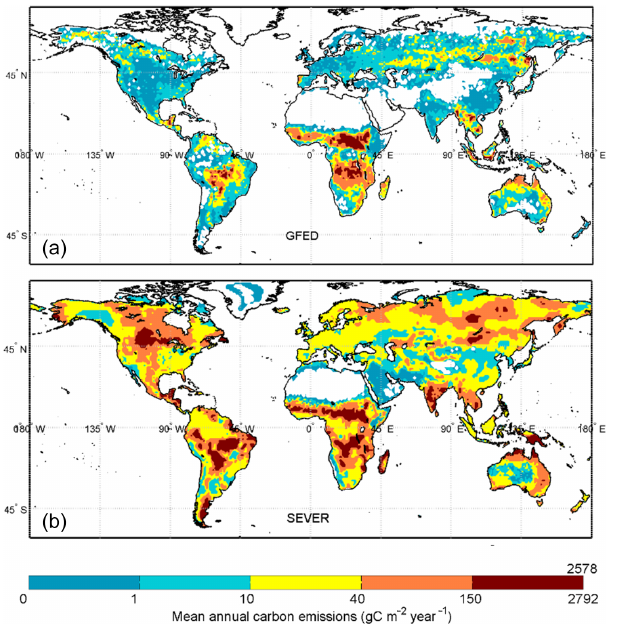
Figure 9. Mean annual emissions (gCm − 2 yr − 1 ) over 1997–2006. (a) GFED; (b) SEVER-FIRE.